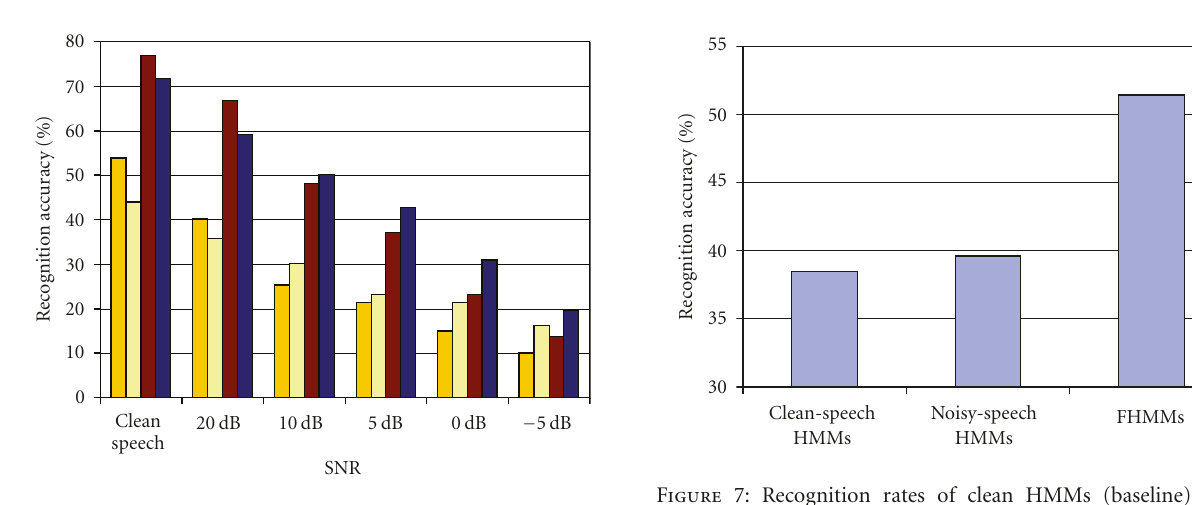
Figure 7: Recognition rates of clean HMMs (baseline), noisy HMMs, and noisy FHMMs for recorded noisy